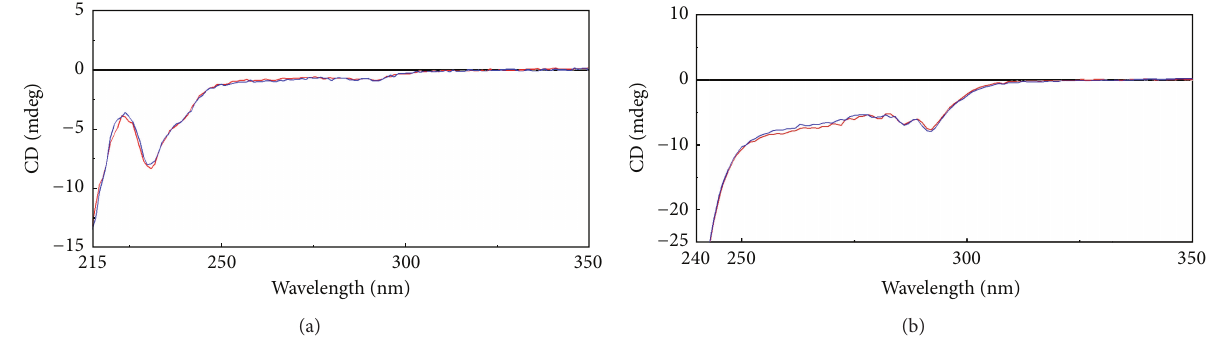
Figure 2: CD spectra of Infinitam (blue) and the reference product (red). (a) Far UV region and (b) near UV